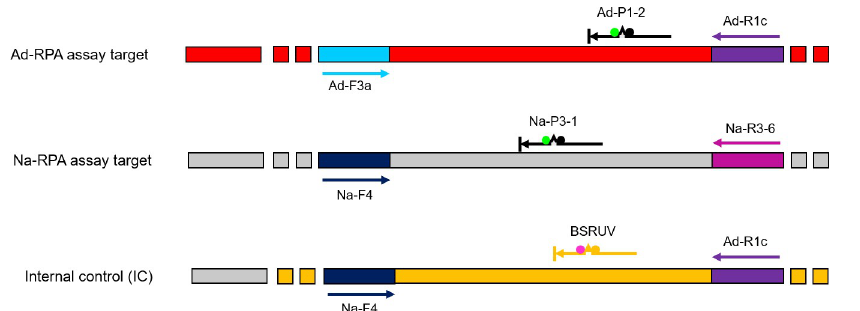
Fig 1. Development of an internal control (IC). A short section of Bacillus subtilis gDNA was amplified using primers tailed with Ad- or Na-RPA primer sequences, and the resulting PCR product was cloned into a plasmid. The plasmid construct (IC) contains the Na-F4 (dark blue) and Ad-R1c (purple) primer binding sites. BSRUVB probe designed to target the B . subtilis DNA fragment [42] is shown in yellow, while Na and Ad probes are in black. In RPA assay, the IC is amplified by the Na-F4 and Ad-R1c primers and the amplicon detected by